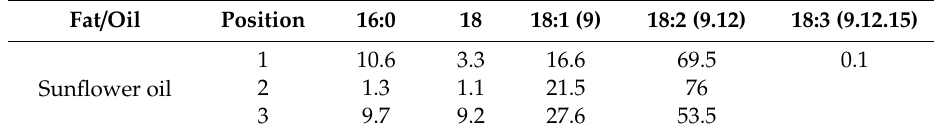
Table 1. Fatty acids of sunflower oil and specific stereo analysis [10]. Results are provided in % moles. Fat / Oil